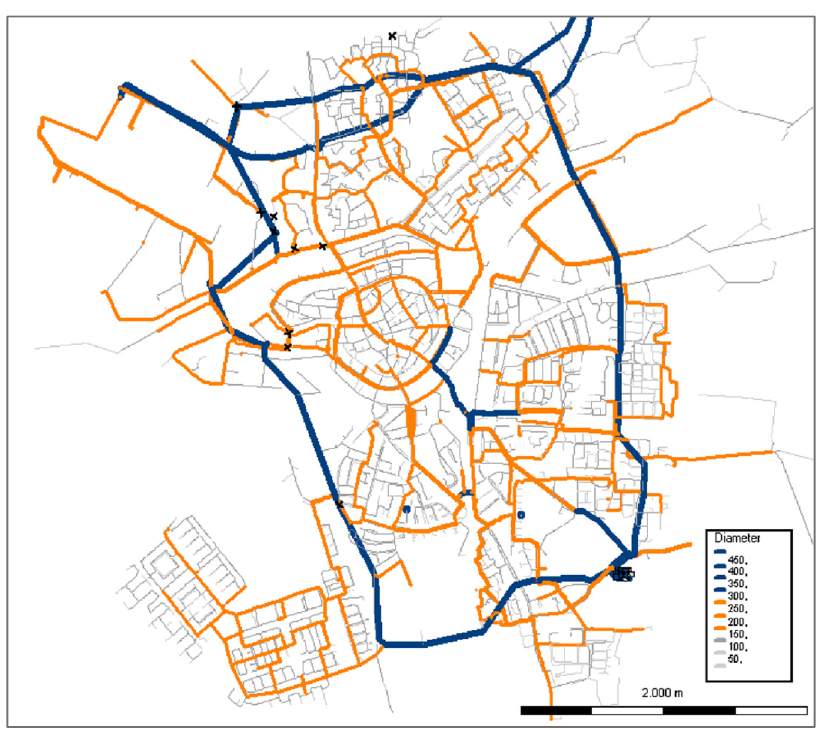
Figure 1. Illustration of the structured design of a WDN according to Dutch best practices, i.e., considering primary (blue), secondary (orange) and tertiary pipes (grey) [26].